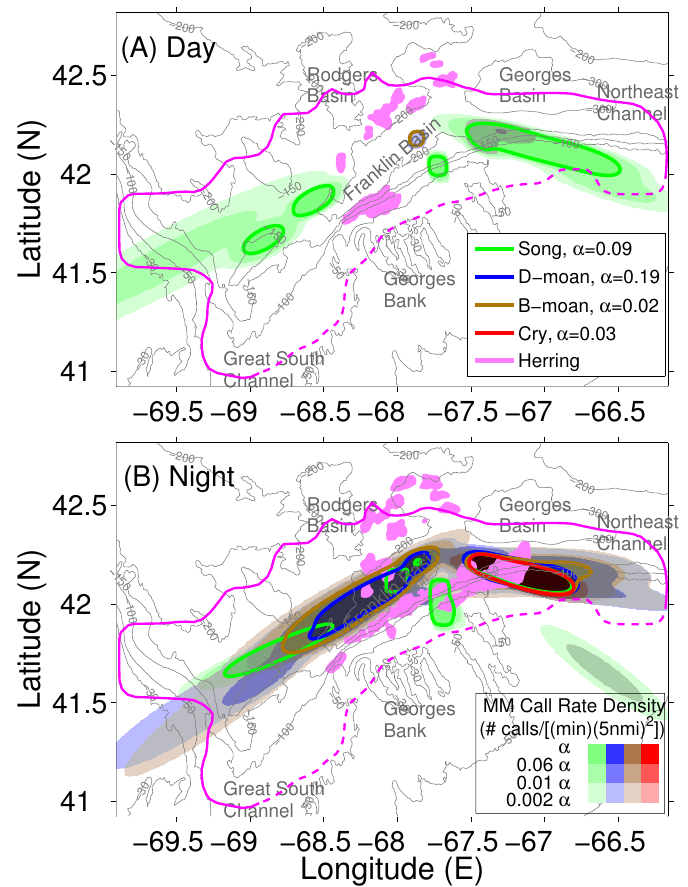
Figure 7. ( A ) Day, and ( B ) night spatial distributions of call rates for different humpback vocalization types and Atlantic herring population. All data are averaged between 27 September and 3 October 2006 for ( A ) daytime hours between sunrise and sunset (06:00 to 18:00 EDT) and ( B ) nighttime hours between sunset and sunrise (18:00 to next day 06:00 EDT). Dense Atlantic herring shoals (>0.2 fish/m 2 , magenta shaded areas) imaged using OAWRS system [12,13,15] and diffuse herring populations (approximately 0.053 fish/m 2 , bounded by magenta line) obtained from conventional fish finding sonar [16,49] line-transect data from NMFS Annual Fall Herring Surveys. The dashed magenta line represents the southern bound of the NMFS survey tracks. The humpback call rate densities in units of number of calls per minute per 25 nmi 2 (or units of calls/((min)(5 nmi) 2 )) measured by POAWRS have peak values α for the different call types as